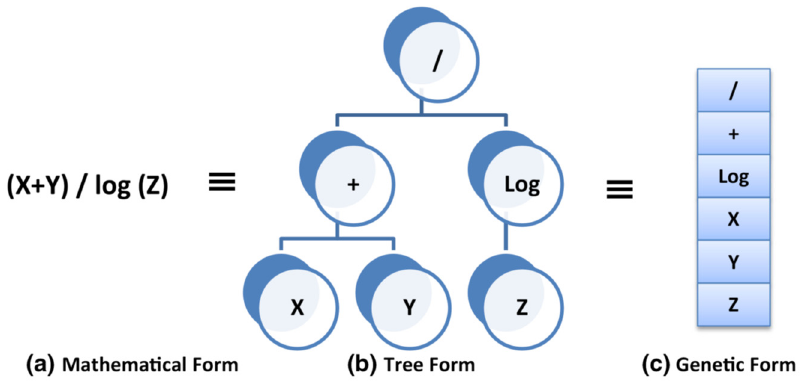
Figure 3. Presentation of mathematical formula in tree and genetic form [47], reproduced with permission from Elsevier.